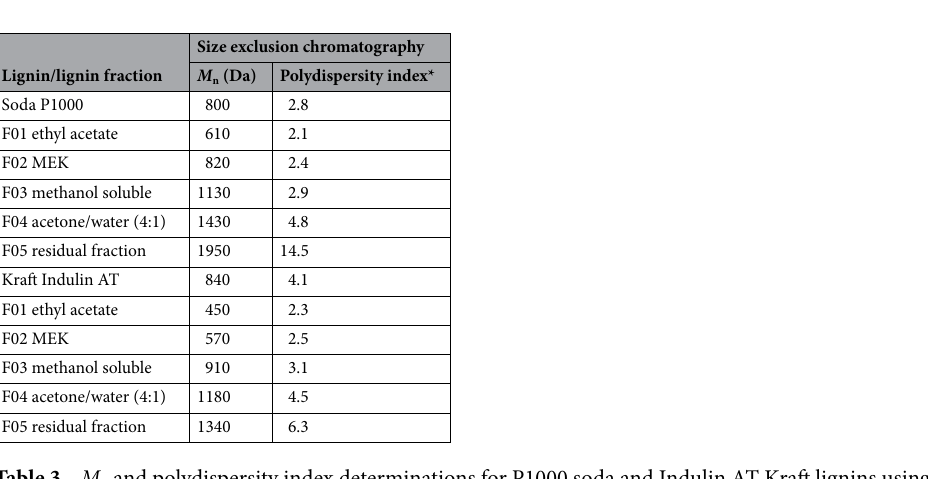
Table 3. M n and polydispersity index determinations for P1000 soda and Indulin AT Kraft lignins using alkaline size exclusion chromatography. * M w / M n .